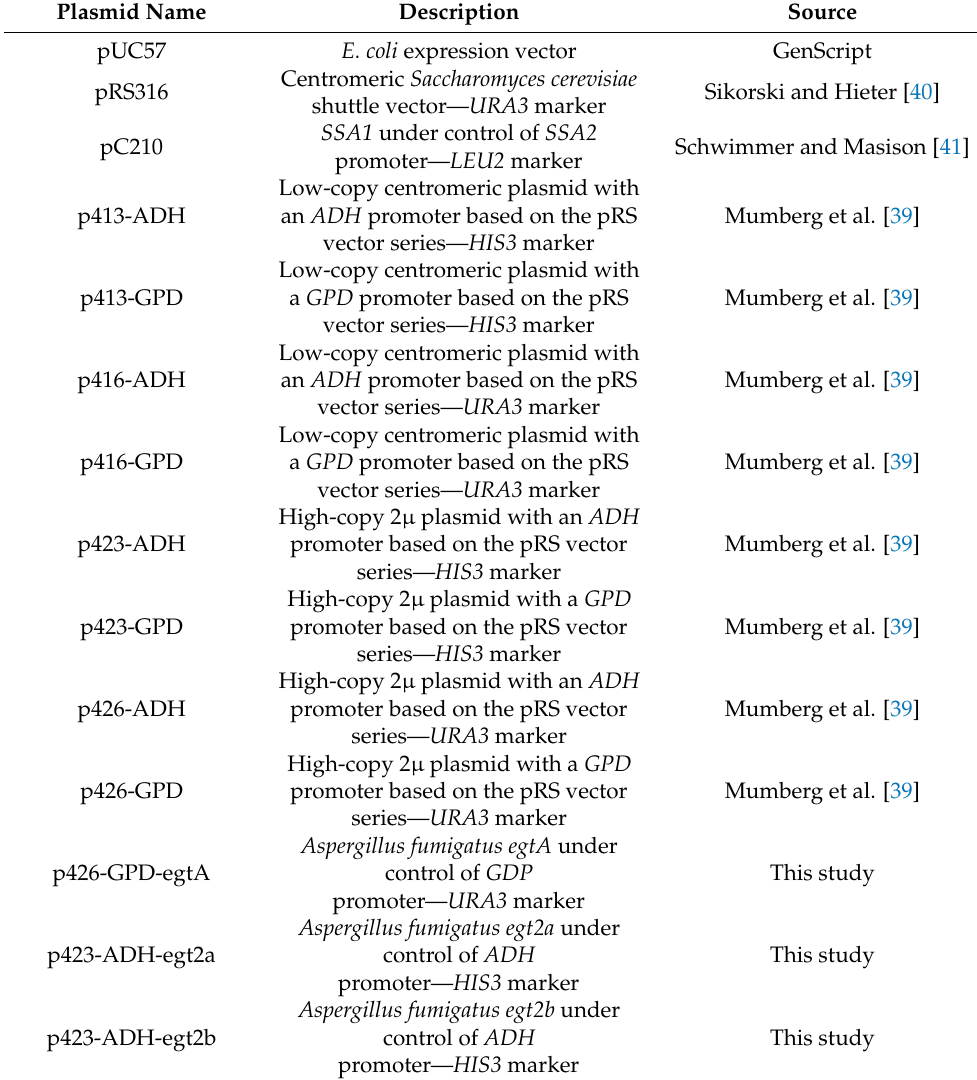
Table 3. Plasmid vectors used in this